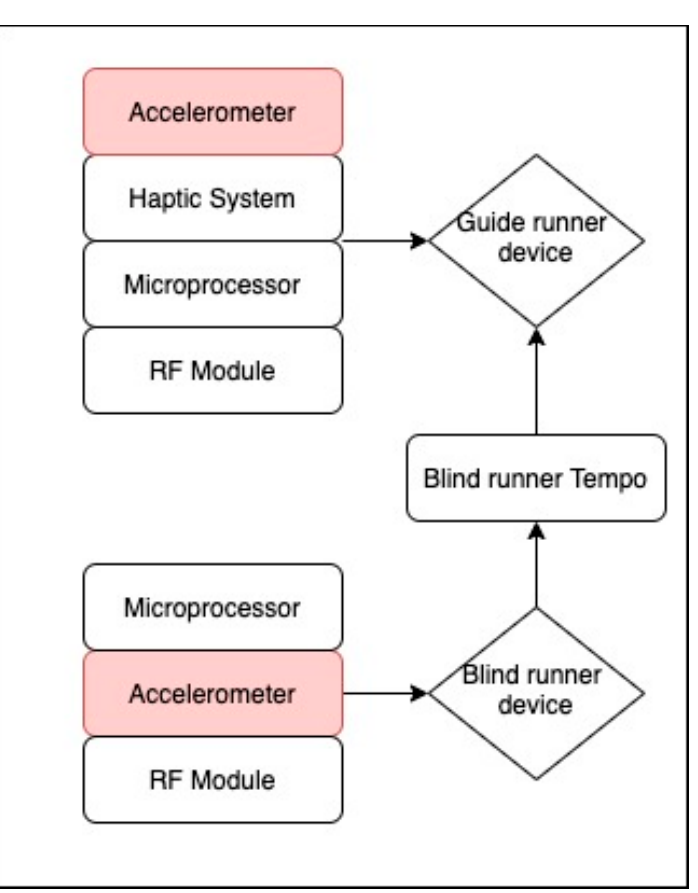
Figure 2. Representation of the algorithm for synchronized running proposed by [64].